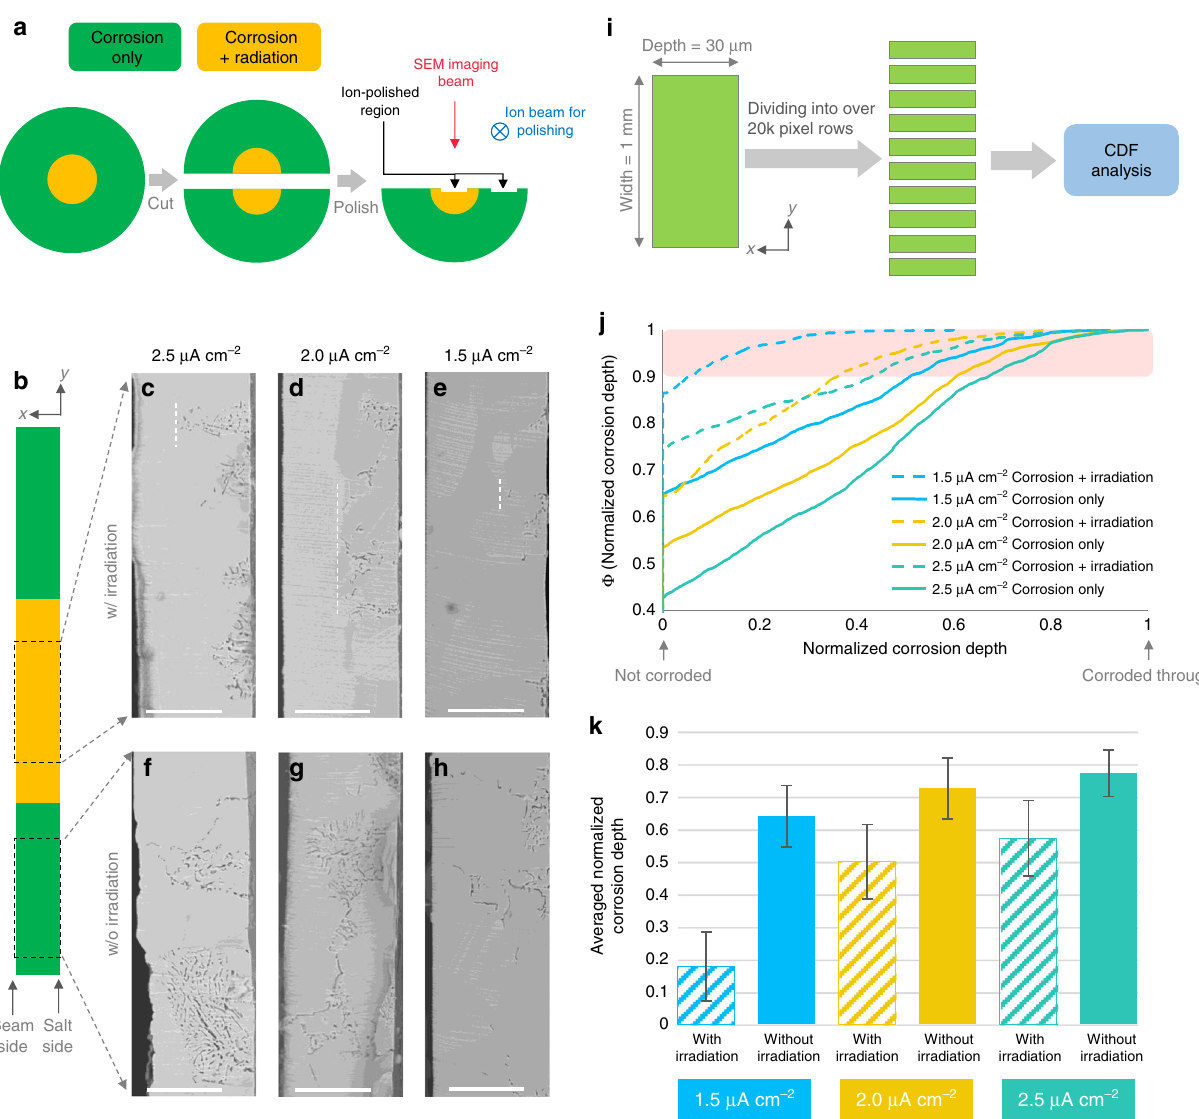
Fig. 2 Cross-sectional comparison of corrosion with and without proton irradiation on Ni-20Cr. a Ion-polishing process used to prepare samples for cross-sectional SEM imaging. b Schematic of the irradiated (in orange) and unirradiated (in green) zones for interpreting zones of SEM images. c – h Representative SEM images from different zones of Ni-20Cr samples under different beam current densities. Scale bar: 20 μ m. c – e Show the irradiated zone, with white dashed-lines indicating the deepest attack. f – h Show the unirradiated zone. i Data analysis process for the Ni-20Cr foils. j Cumulative distribution function (CDF) of normalized corrosion depth, which is de fi ned as corrosion depth normalized by sample thickness using data obtained by process in i . Dash lines represent data from the corrosion/irradiation region. Solid lines represent data from the corrosion only region. Blue, yellow, and dark green represent beam current densities of 1.5, 2.0, and 2.5 μ A cm − 2 , respectively. k Average, normalized corrosion depth using data from the 10% deepest corroded regions of each sample, as illustrated by the light red bar in j . Diagonal- fi lled bars represent data from corrosion/irradiation region. Solid bars represent data from corrosion only region. Meaning of colors is the same with j . Error bars denote one standard